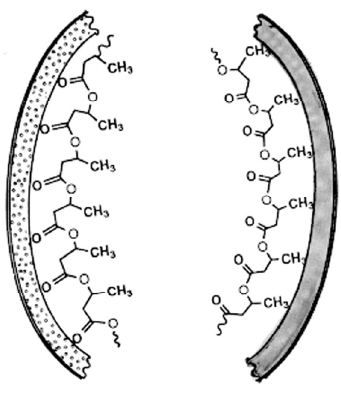
Figure 4. Sketch illustrating possible modes of noncovalent binding of cPHB to hydrophobic (shaded) and polar (dotted) region in polypeptides, thereby reversing their polarity. From Reusch and Gruhn, (1997) [44].